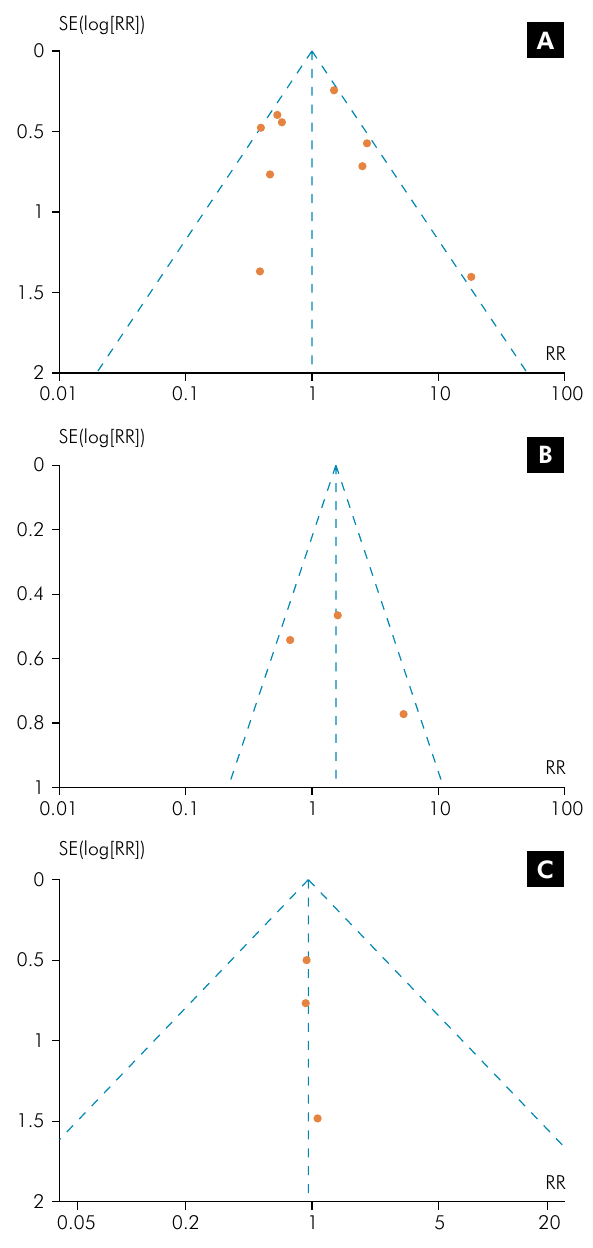
Figure 5. Funnel plot for the included studies. A: Complication rates of PMMA versus autologous bone grafts; B: PMMA versus titanium mesh; C: Trauma versus